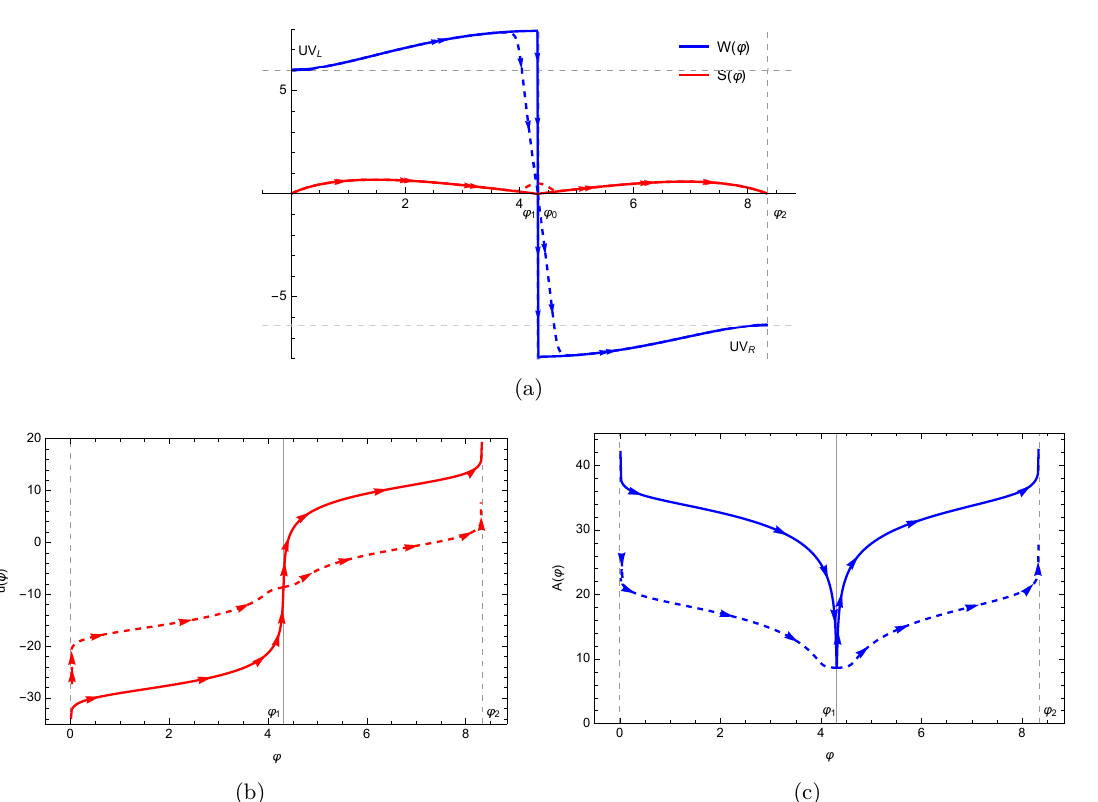
Figure 47 . Along the fixed line ϕ 0 = ϕ 1 i.e. the minimum of the potential, see figure 10a, if we decrease the value of S down to zero, gradually the dashed curves in all figures above move toward 0 the solid curves. In the above curves the dashed curves have S